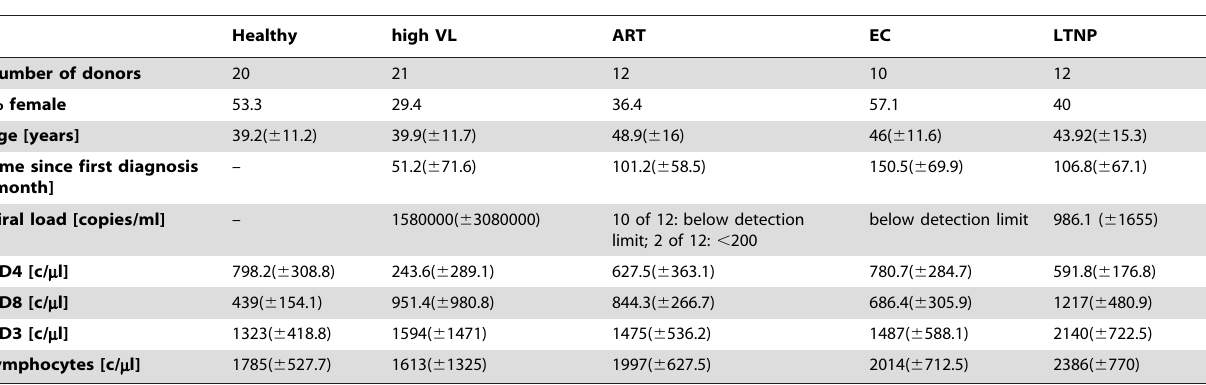
Table 1. Cohort (PBMC